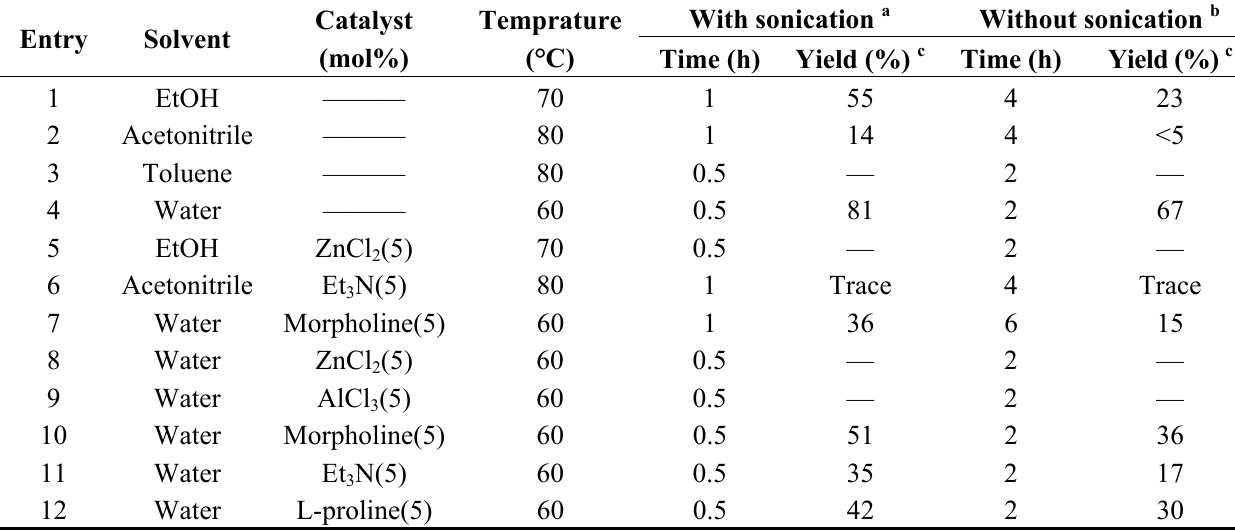
Table 1. The effect of the reaction conditions for the synthesis of 4a under ultrasound